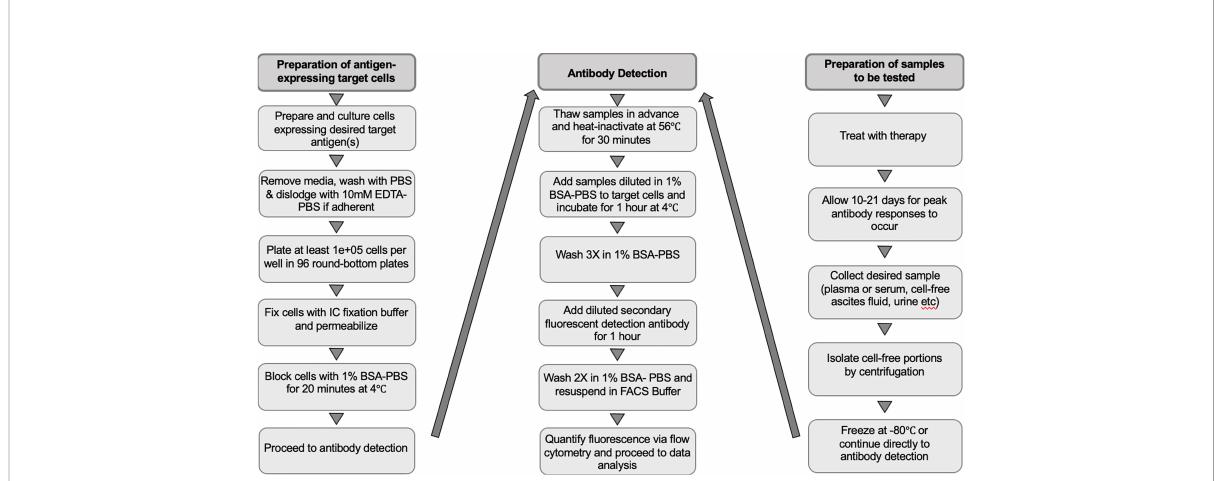
FIGURE 1 Work fl ow of the experimental procedure for preparing target cells, collecting samples to be tested and detecting immunotherapy-induced antibodies. EDTA-PBS, ethylenediaminetetra-acetic acid-phosphate-buffered saline; BSA-PBS, bovine serum albumin-phosphate buffered saline; FACS, fl uorescence-activated cell scanning; IC,